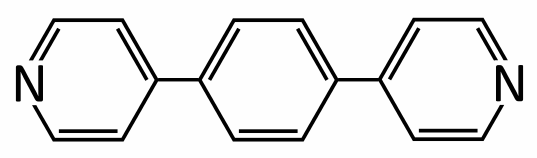
Figure 1. 1,4-bis(4-pyridyl)benzene implemented in the